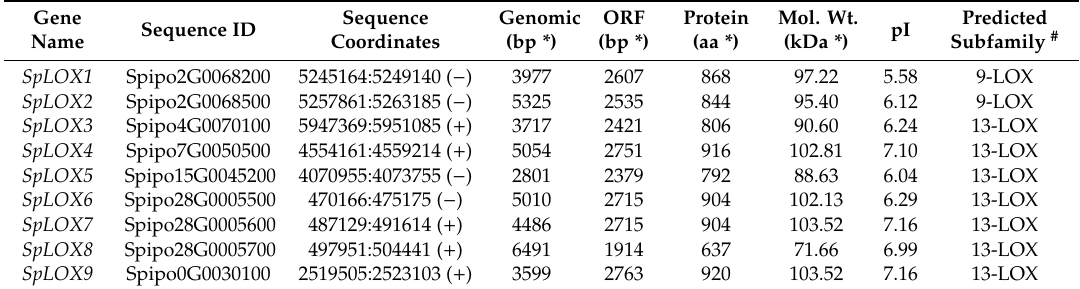
Table 1. Identification of bona fide lipoxygenase (LOX) genes annotated in the genome of Spirodela polyrhiza